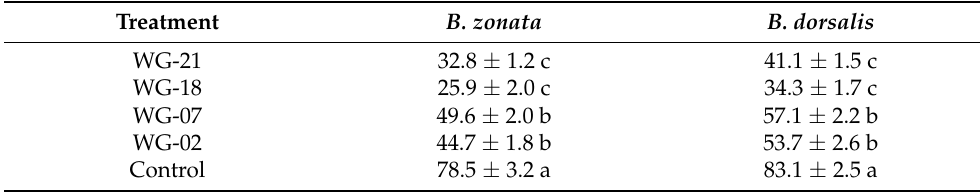
Table 11. The percentage of adult emergence (mean ± SEM) in B. zonata and B. dorsalis when four isolates (WG-21, WG-18, WG-07, and WG-02) of entomopathogenic fungi were applied against third instar larvae in a field-cage test. Same letters within the column indicate no significant differences between isolates ( p < 0.05; Tukey HSD